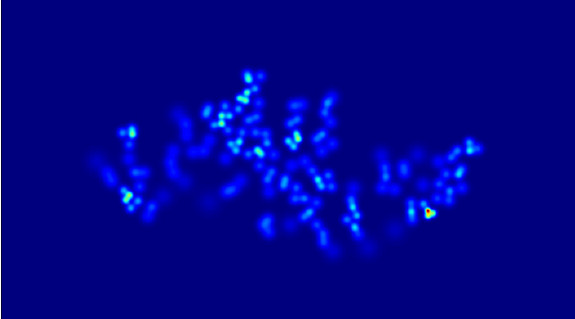
Figure 7. Ground-truth of peach flower density map.